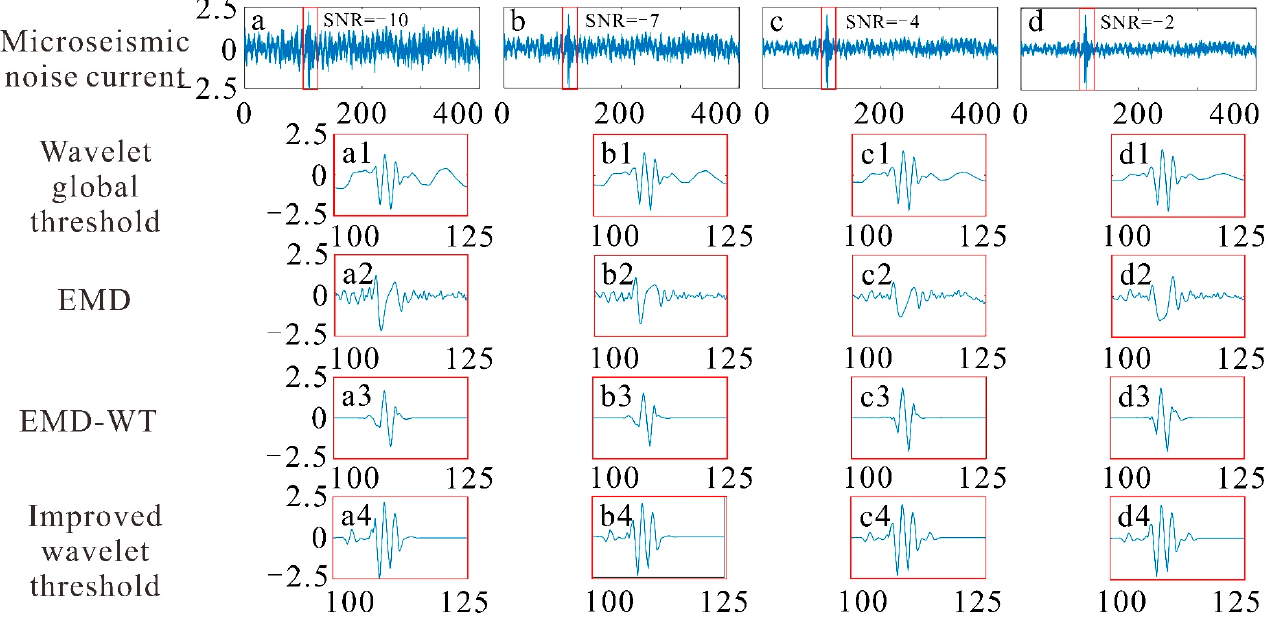
Figure 9. Comparison of the denoising of synthesized microseismic current signals with different SNRs: ( a ) microseismic current of SNR = − 10, ( b ) microseismic current of SNR = − 7, ( c ) microseismic current of SNR = − 4, ( d ) microseismic current noise of SNR = − 2, ( a1 , b1 , c1 , d1 ) Wavelet global threshold denoising signal, ( a2 , b2 , c2 , d2 ) EMD denoising signal, ( a3 , b3 , c3 , d3 ) EMD-WT denoising signal, ( a4 , b4 , c4 , d4 ) improved wavelet threshold denoising signal.